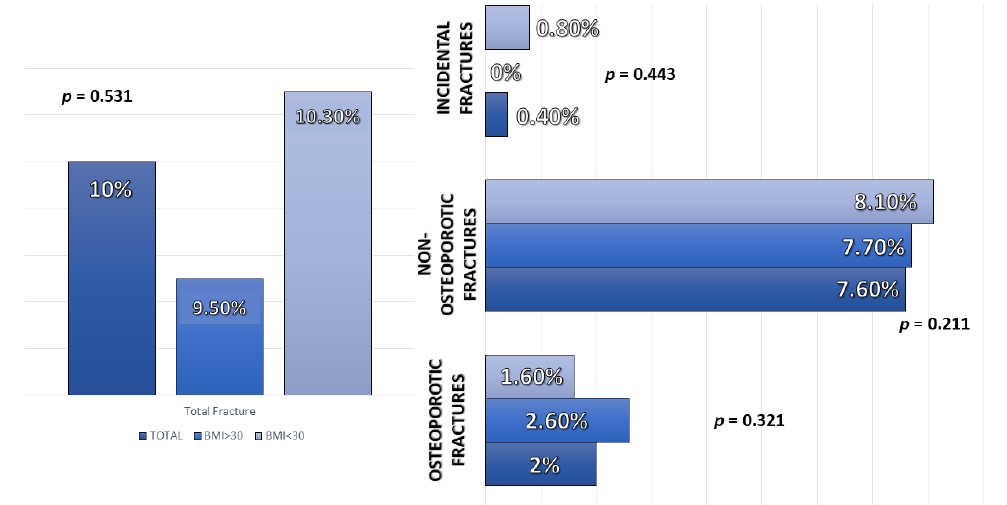
Figure 1. Differences in type fracture depending on body mass index (BMI).